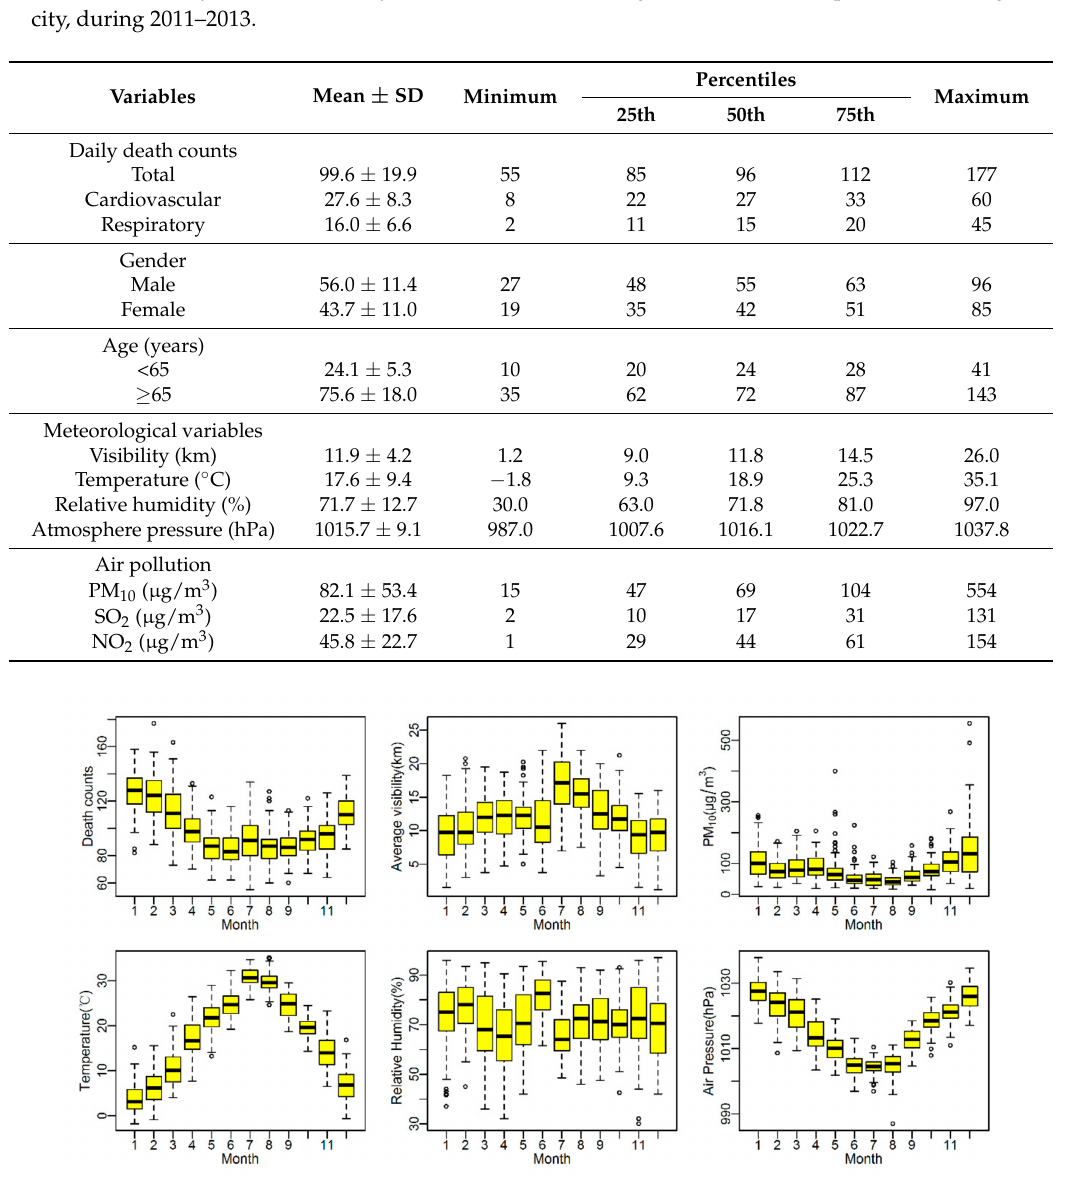
Figure 1. Boxplots of monthly death counts, PM 10 concentration, temperature, relative humidity, air pressure and average visibility in Ningbo, China, 2011–2013.